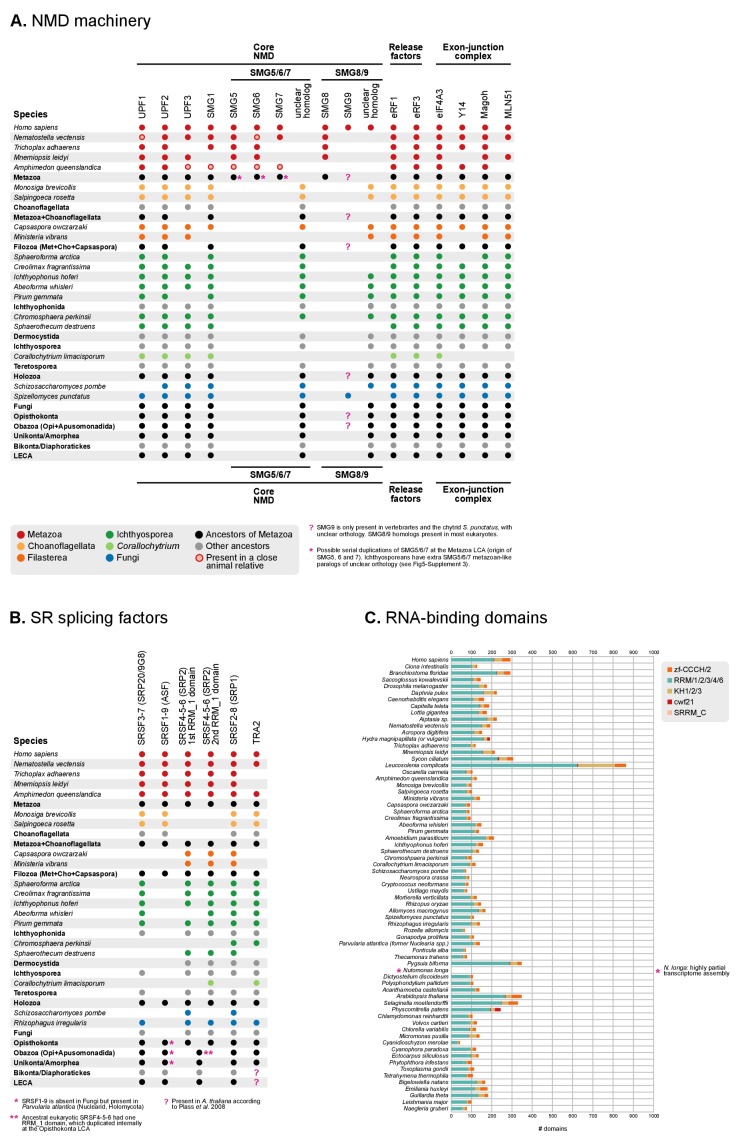
Phylogenetic distribution of the NMD machinery, SR splicing factors and RNA-binding domains in eukaryotes.(A) Phylogenetic distribution of the NMD molecular toolkit across eukaryotes, as defined in Whelan et al. (2015), with a focus on unicellular holozoans and selected metazoans. The analysis includes 12 gene families: the core regulatory factors Upf1, Upf2 and Upf3 (also Smg2-4); the accessory proteins Smg1, Smg5/6/7 and Smg8/9; the release factors eRF1 and eRF3; and the exon junction complex (EJC) proteins eIF4A3, Y14, Magoh and MLN51. Extant species are color-coded by taxonomic assignment. Black dots indicate reconstructed LCAs within the line of descent between Metazoa and the LECA, whereas gray dots indicate LCAs not affiliated with Metaoza. Red, hollow circles indicate that a specific gene is absent from a given animal genome, but nevertheless present in a close relative in the same lineage (e.g., poriferans other than Amphimedon). See Methods for details on ortholog identification. Complete survey at the species level available as Figure 5—source data 3. Note that the core NMD tool-kit is conserved in most post-LECA LCAs, both in the animal and ichthyophonid ancestry. Secondary losses affect extant taxa: Corallochytrium lacks the complete EJC (only eIF4A3 is conserved) and homologs of Smg5/6/7 and Smg8/9. (B) Phylogenetic distribution of the SR splicing factors involved in alternative splicing determination across eukaryotes, as defined in Plass et al. (2008), with a focus on unicellular holozoans and selected metazoans. The analysis is focused on the following RNA-binding genes: SRP20/9G8 (human paralogs SRSF3/7), ASF (human paralogs SRSF1/9), SRP2 (human paralogs SRSF4/5/6), SRP1 (human paralogs SRSF2/8) and TRA2 (human paralogs TRA2A/B). Extant species are color-coded by taxonomic assignment. Black dots indicate reconstructed LCAs within the line of descent between Metazoa and the LECA, whereas gray dots indicate LCAs not affiliated with Metaoza. See Methods for details on ortholog identification. Complete survey at the species level available as Figure 5—source data 3. Note that the complement of SR genes is conserved in most post-LECA LCAs, including Opisthokonta, Holozoa and Metazoa. Secondary losses are, however, frequent in some lineages: SRSF1/9 is lost in Fungi, Teretosporea and Filasterea; Corallochytrium lacks all canonical SR genes but TRA2 and a fragmentary SRSF4/5/6; choanoflagellates have lost SRSF4/5/6, etc. (C) Counts of RNA-binding protein domains in extant eukaryotic genomes. Unicellular holozoans have a rich complement of RNA-binding proteins (domains per species: average 127.8; median 120), albeit less abundant than metazoans’ (domains per species: average 225.3; median 187).